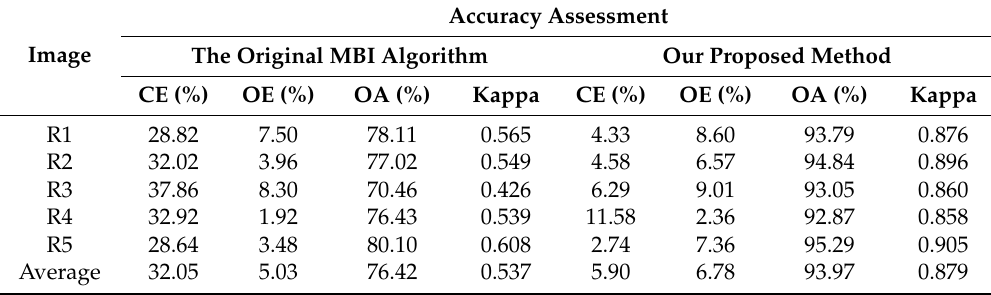
Table 6. Accuracy assessment of building detection for the original MBI algorithm and our method.